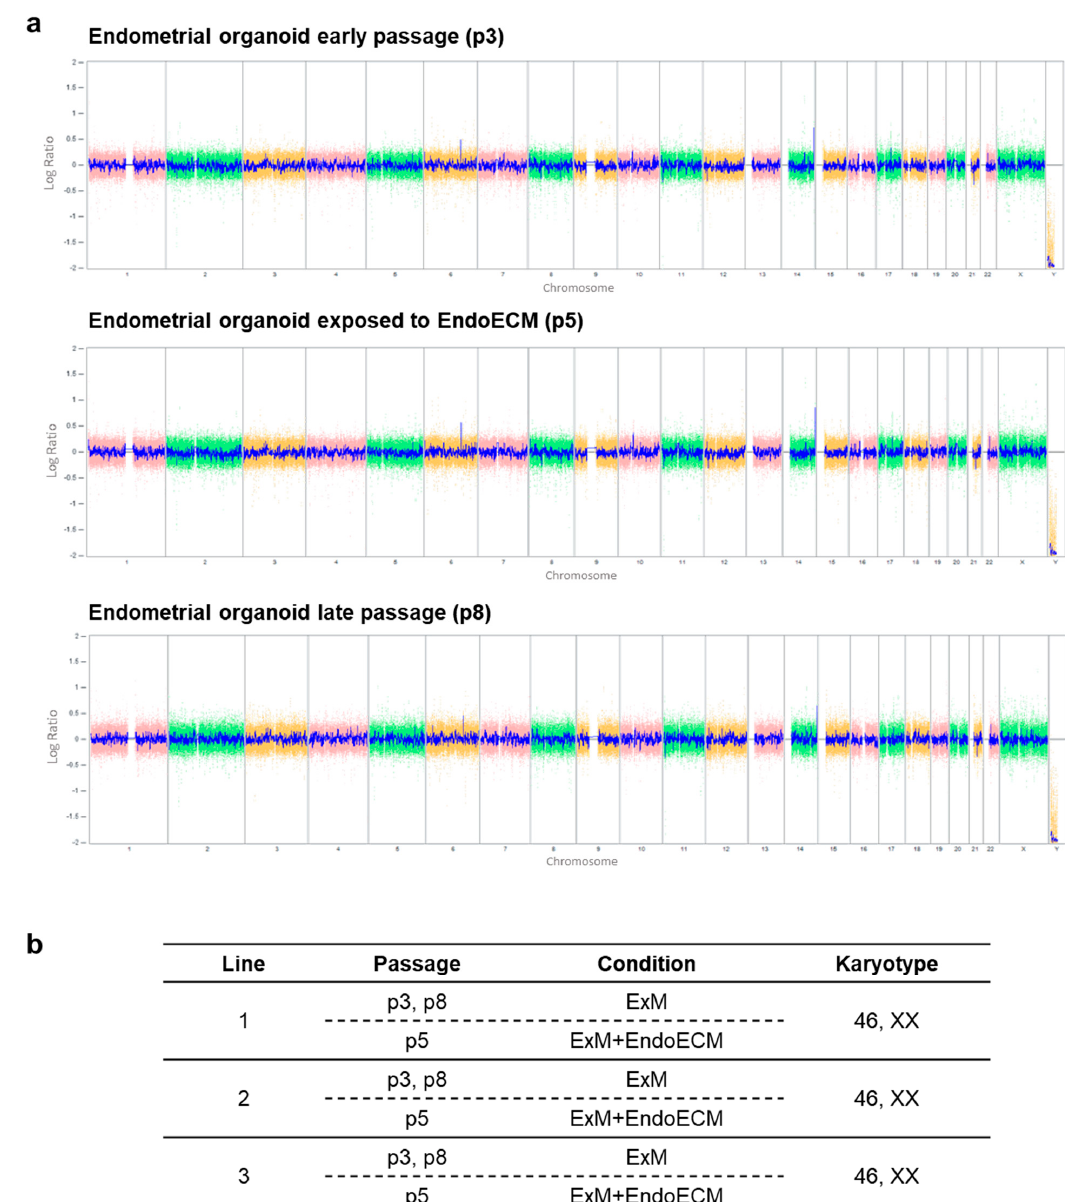
Figure 4. Chromosomal analysis of human endometrial organoids by cytogenetic microarray. ( a ) Genomic DNAs from early (p3), mid (p5), and late (p8) passage organoids exposed to ExM and EndoECM culture conditions are compared with a human reference genome. Intensity of each probe (log ratio) is expressed on the Y-axis and its location on chromosomes (1–22, X and Y) on the X-axis. A signal ratio of 0 indicates copy number equivalence. Reduced signal on the Y chromosome is not significant due to the absence of this chromosome in the samples. ( b ) Summary of genetic analyses.